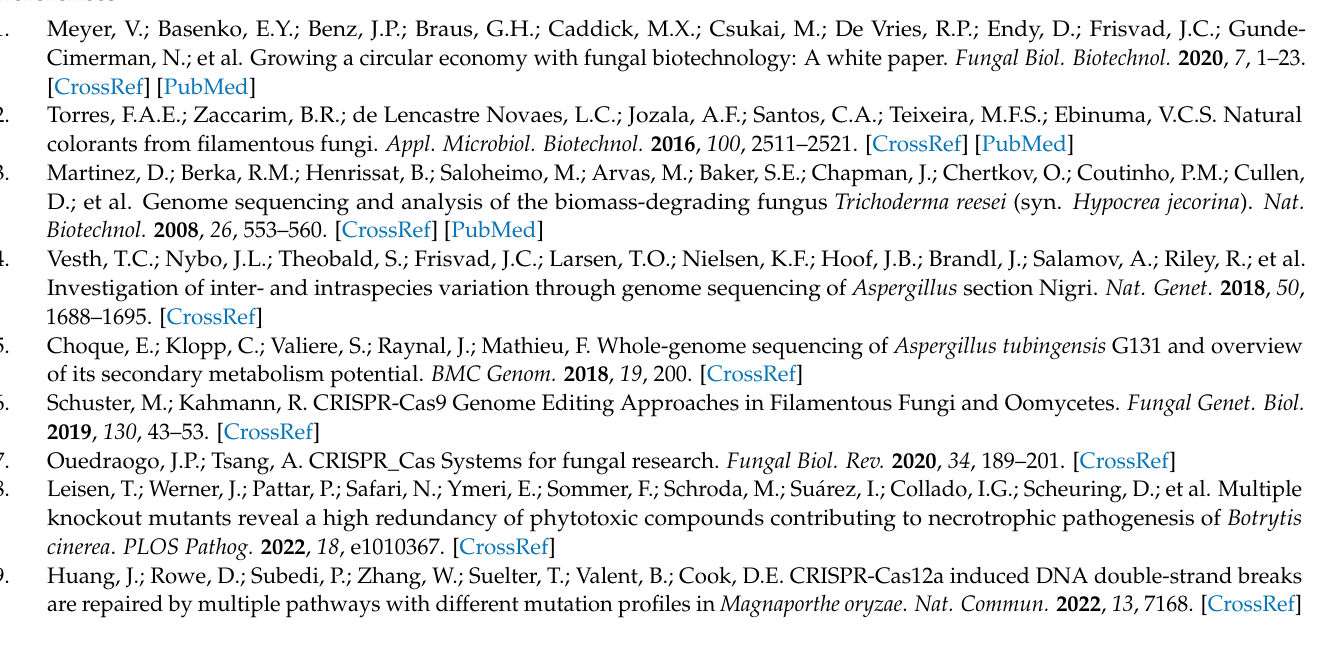
Figure S1: Primer design for construction of gRNA expression cassettes; Figure S2: Single-stranded oligonucleotide-mediated site-specific mutagenesis in A. nidulans ; Figure S3: Mad7-induced gene insertion in A. nidulans ; Figure S4: Single-stranded oligonucleotide-mediated site-specific